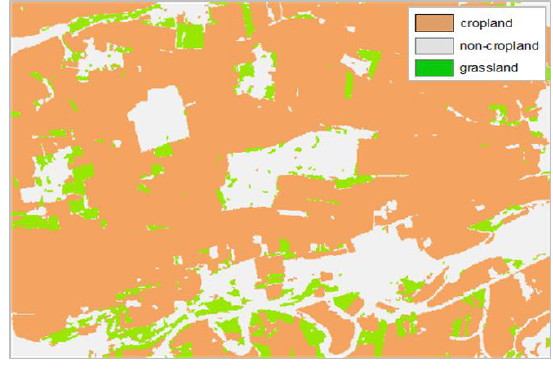
Figure 4. Crop mask 2018 (detail) together with the Grassland mask 2018 Different methods are applied for crop type classification